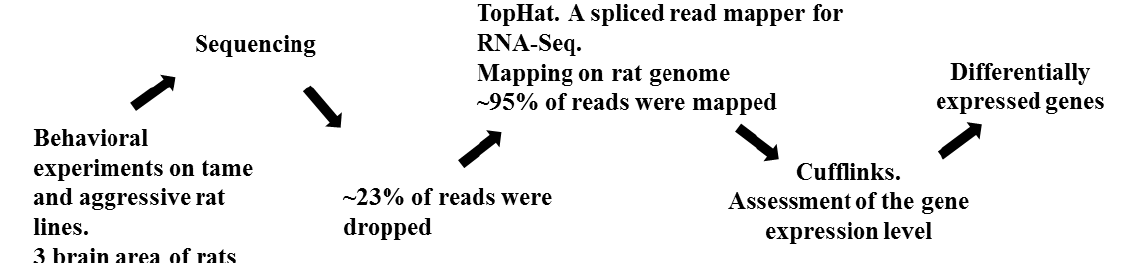
Figure 1: Block scheme for analysis of differentially expressed genes in